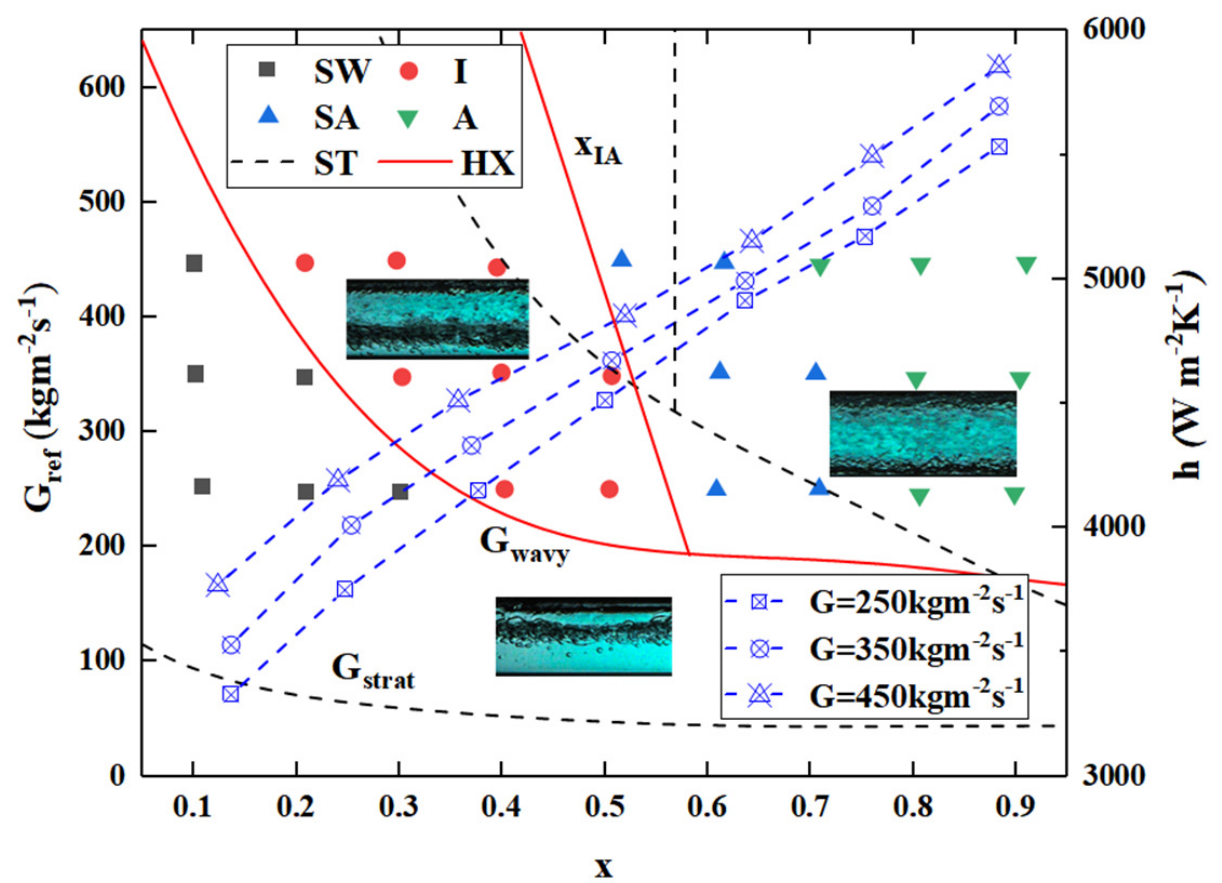
Figure 12. Flow patterns and HTC of the Copper HX tube at different mass flow